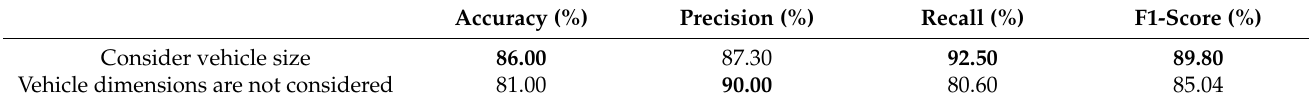
Table 12. Comparison of model results considering and not considering vehicle size